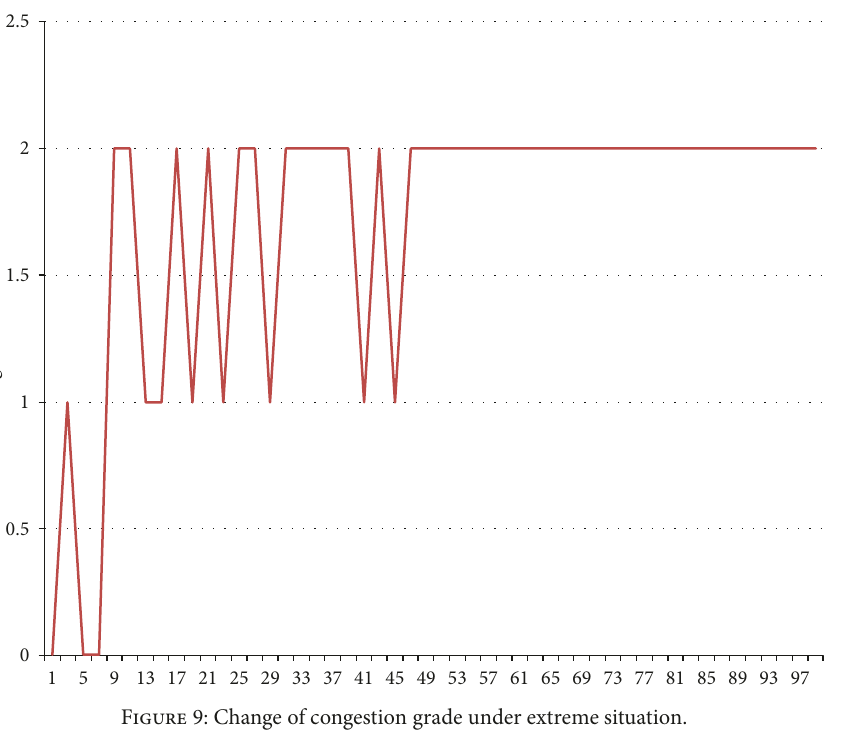
Figure 9: Change of congestion grade under extreme situation.